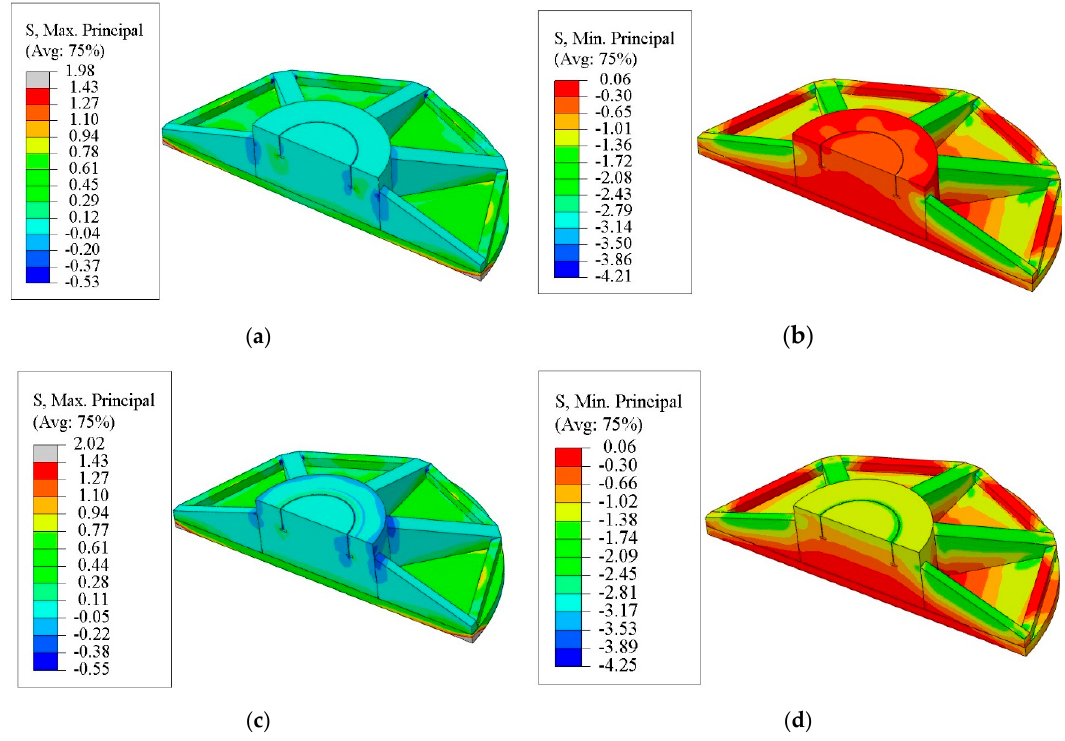
Figure 15. Maximum and minimum principal stress of the foundation concrete before and after strengthening under the valley value of fatigue loading (MPa). ( a ) Maximum principal stress before strengthening; ( b ) Minimum principal stress before strengthening; ( c ) Maximum principal stress after strengthening; ( d ) Minimum principal stress after strengthening.